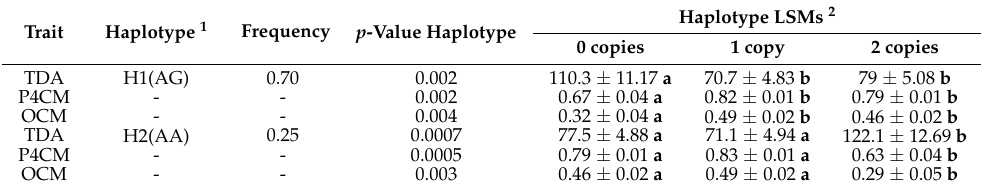
Table 5. Type III test for the haplotype effects for block 2 of the CD226 gene using seasonal phenotypic data from Rasa Aragonesa ewes (total days of anoestrous (TDA), oestrous cycling month (OCM) and progesterone cycling month (P4CM)). The least square means (LSMs) and standard errors for the haplotype effect are also shown. Only significant haplotypes after Bonferroni correction are shown. Different letters indicate significant differences: a , b : p <